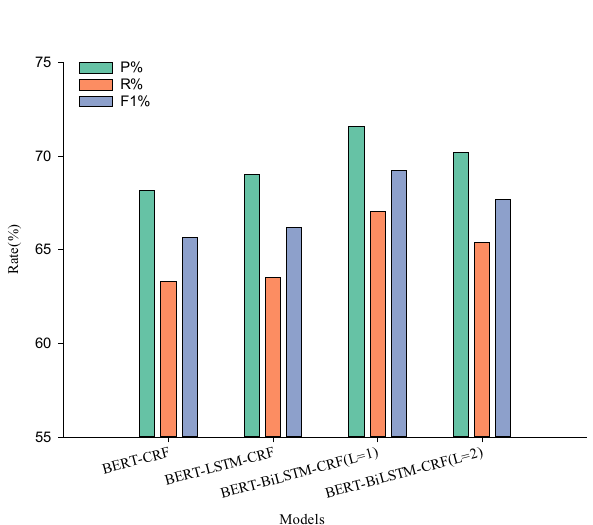
Fig. 5 Comparison of experimental results of different